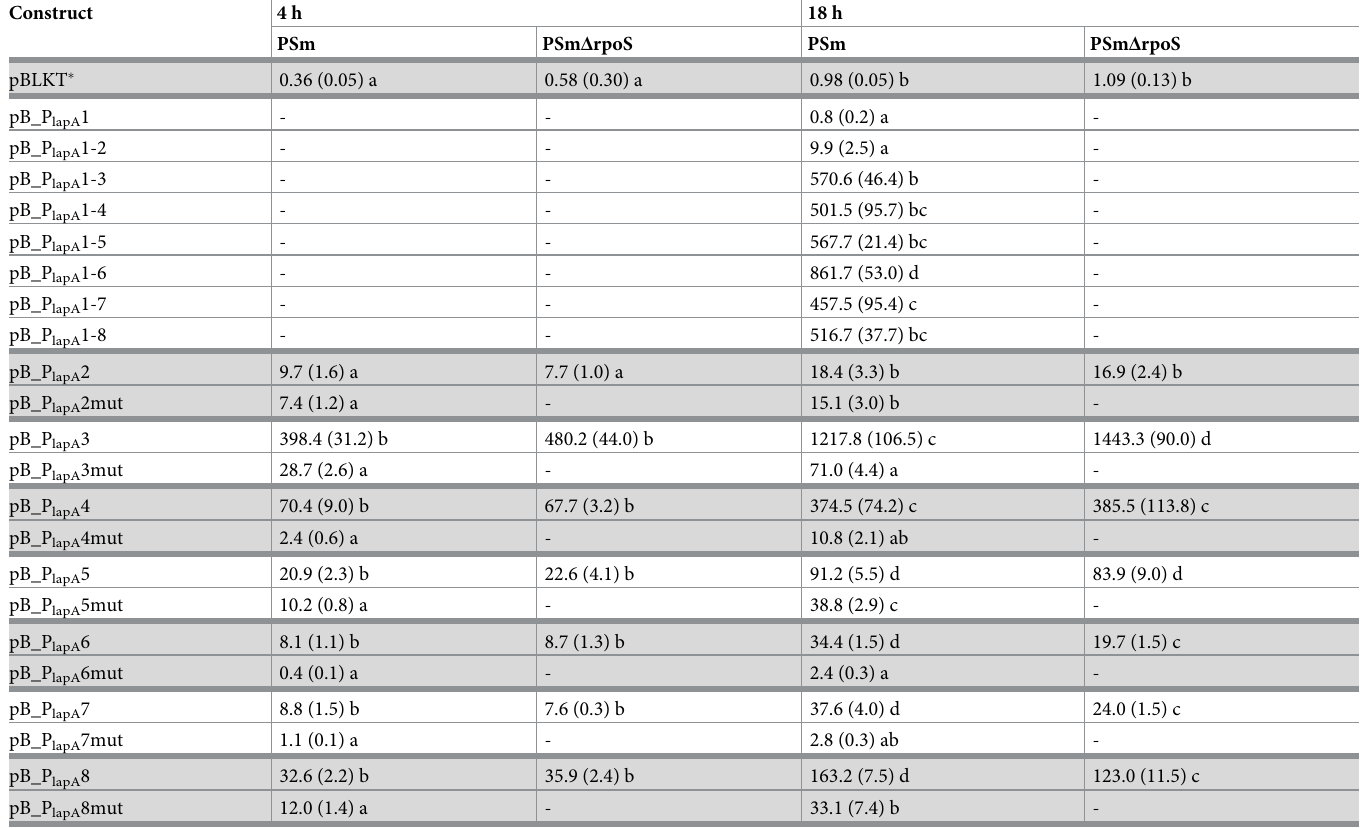
(cid:3) The promoterless pBLKT does not contain lapA upstream DNA. Data from at least 5 independent measurements is shown. 95% confidence intervals are shown in parentheses. Not determined activities are marked with the “-”symbol. Groups of data analysed separately are divided by bold horizontal lines and background colour. Letters a-e depict different homogeneity groups according to ANOVA post hoc Bonferroni test. Identical letters denote non-significant differences ( P > 0.05) between averages of β -galactosidase activity.